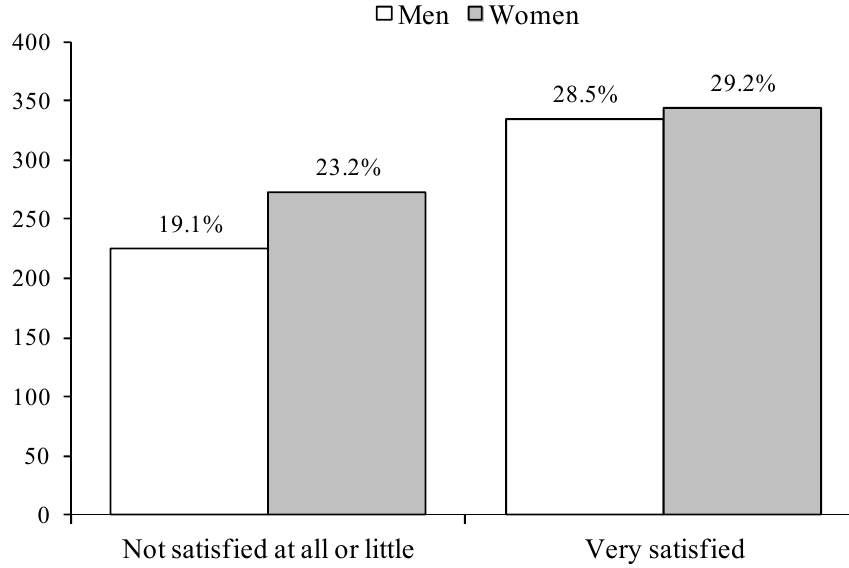
Figure 3. Distribution of the variable Subjective Well-being by sex of the respondents. Source: Own elaboration based on FOUM.